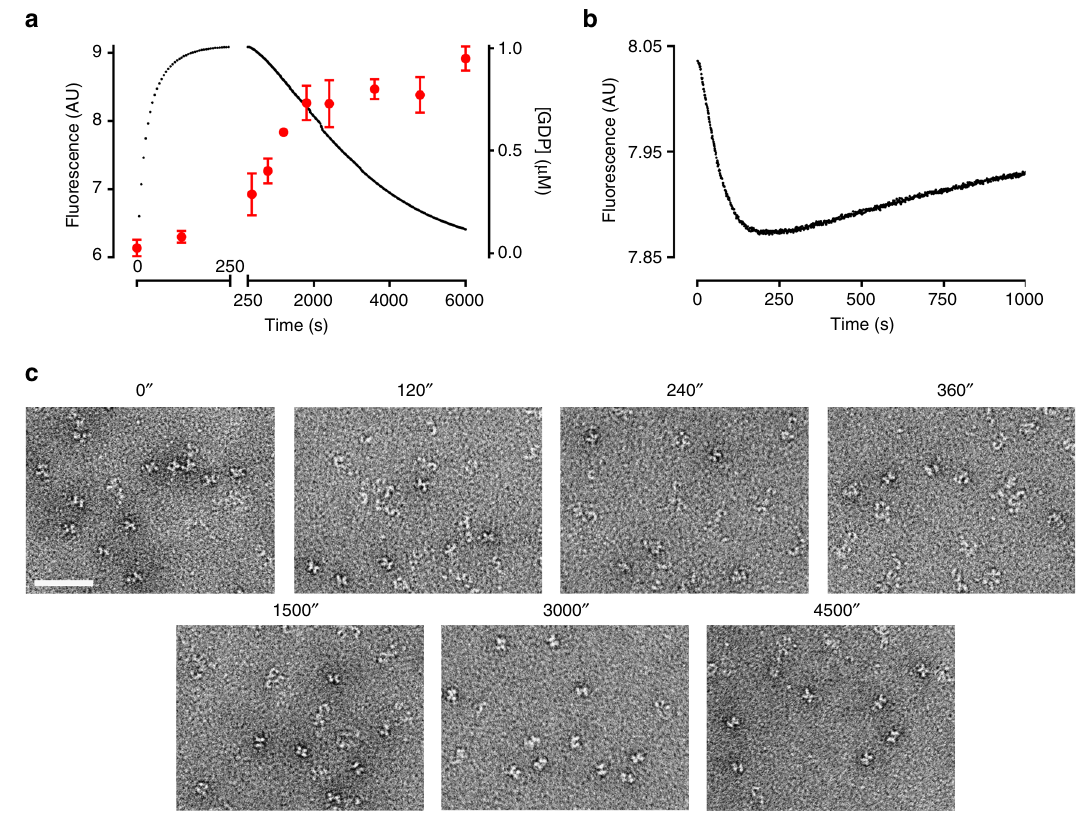
Fig. 4 The Chlorobium tepidum Roco protein undergoes a monomer-dimer cycle during GTP turnover. a Single turnover (mant-)GTP hydrolysis by CtRoc- COR (S928C) followed by stopped fl ow fl uorescence ( black curve ) and reversed-phase HPLC ( red data points; each data point is the average ( ± s.d.) of 3 independent measurements). Rapid mixing of 1 µ M mant-GTP and 1 µ M unlabeled CtRoc-COR (S928C) in a stopped- fl ow apparatus yields a rapid increase in fl uorescence (time frame 1 – 250 s), followed by a slow decrease in a time frame of 6000 s. Following production of GDP from GTP in time via reversed- phase HPLC shows that the increase in fl uorescence occurs prior to GDP production while all GTP is converted in the time scale of 6000 s. A split time axis is used to highlight the two phases: fast fl uorescence increase associated with GTP binding and slow fl uorescence decrease concomitant with GTP hydrolysis. b Stopped- fl ow FRET signal obtained by mixing 1 µ M of Cy3/Cy5- labeled CtRoc-COR (S928C) with 1 µ M GTP. The traces show relatively fast monomerization ( fi rst phase from 1 – 250 s) followed by a slow return to the dimeric state after GTP hydrolysis. c Single GTP turnover of CtRoco followed by time resolved EM. 1 µ M CtRoco was mixed with 1 µ M GTP and samples were taken at the indicated time points. Representative images for each time point are shown (see also Supplementary Fig. 9) ( scale bar : 50